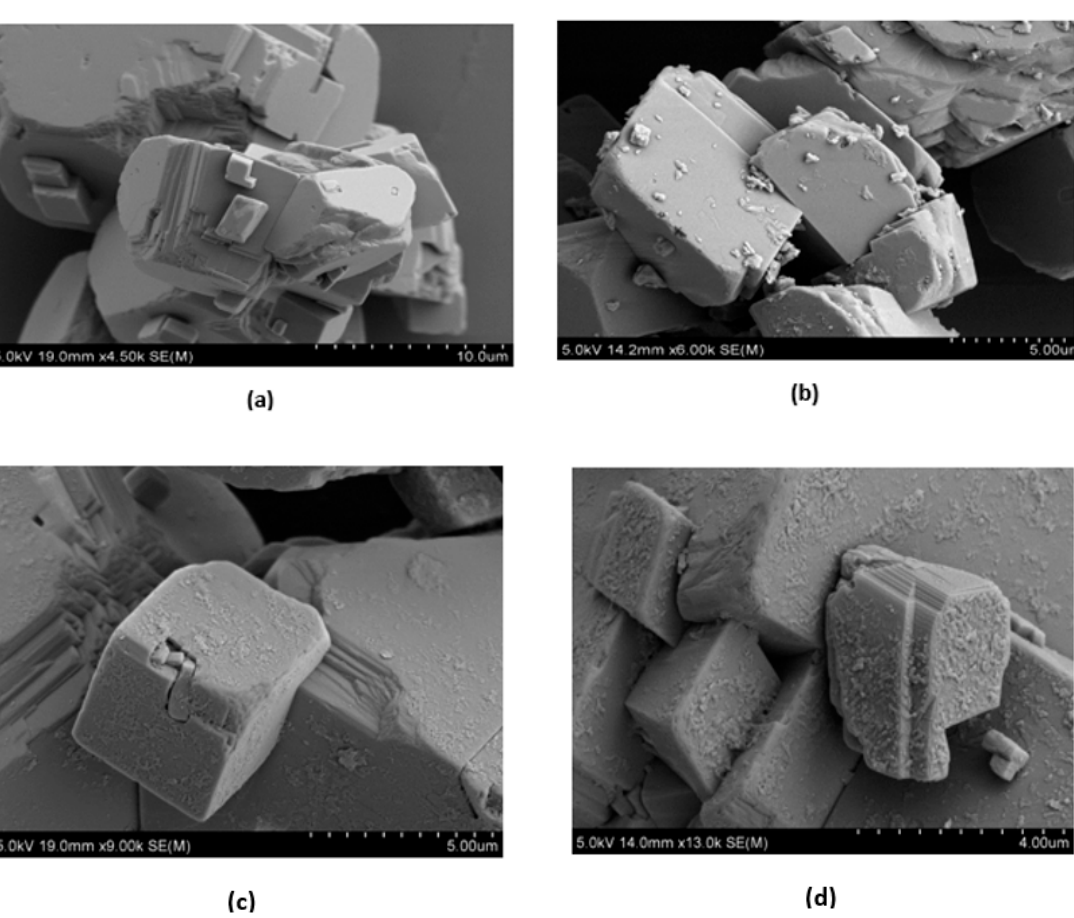
Figure 4. Scanning electron microscopic images of calcium carbonate aged in: ( a ) n -decane without stearic acid; ( b ) 0.001 M stearic acid in n -decane; ( c ) 0.005 M stearic acid in n -decane; ( d ) 0.010 M stearic acid in n -decane.